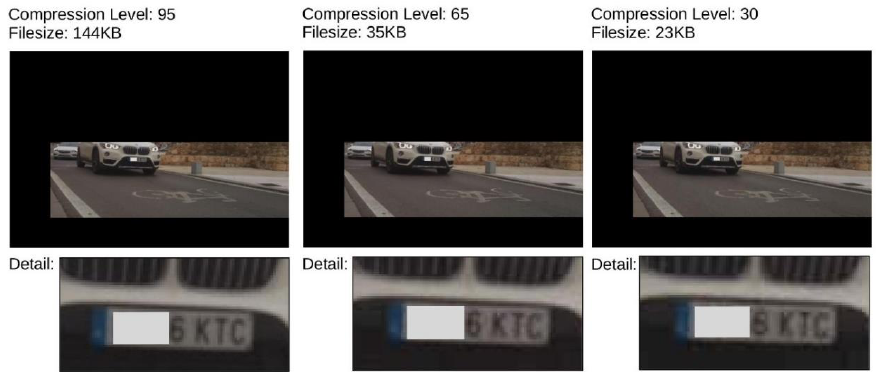
Figure 6. Different compression levels of the JPG standard. With values below 60, with significant